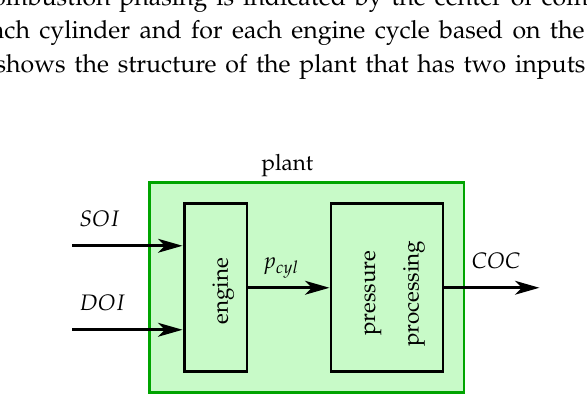
Figure 2. Plant structure: The center of combustion COC as output and the start and the duration of the diesel injection ( SOI and DOI ) as inputs,